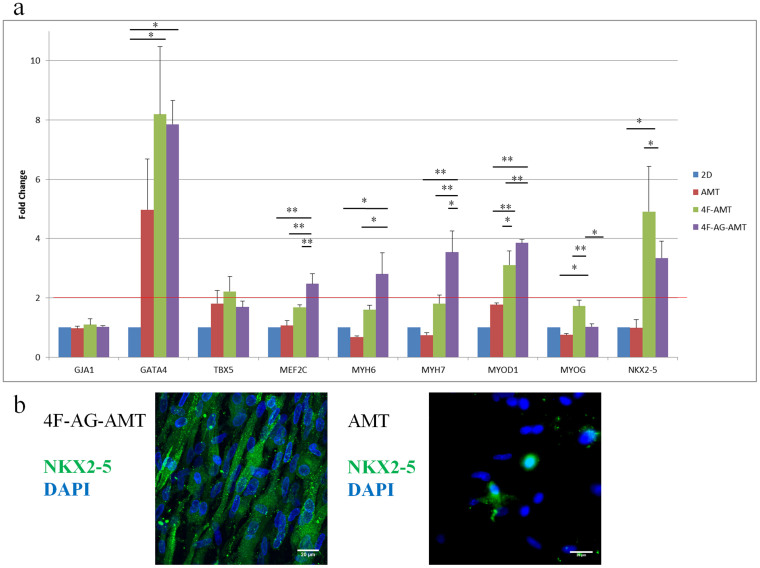
(a) Gene Expression of Day 14 Differentiated MDSCs. Muscle-specific gene expression of MDSCs is dependent on culture conditions. Values are expressed as fold change in gene expression and normalized to 2D differentiation protocol (2D). Red line indicates twofold change. *P < 0.05. **P < 0.001. (b) NKX2-5 protein expression in 4F-AG-AMT and AMT was detected by immunohistochemistry.